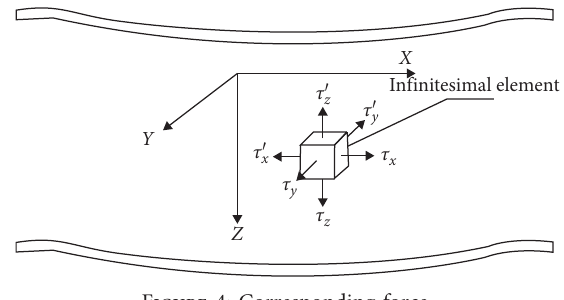
Figure 4: Corresponding